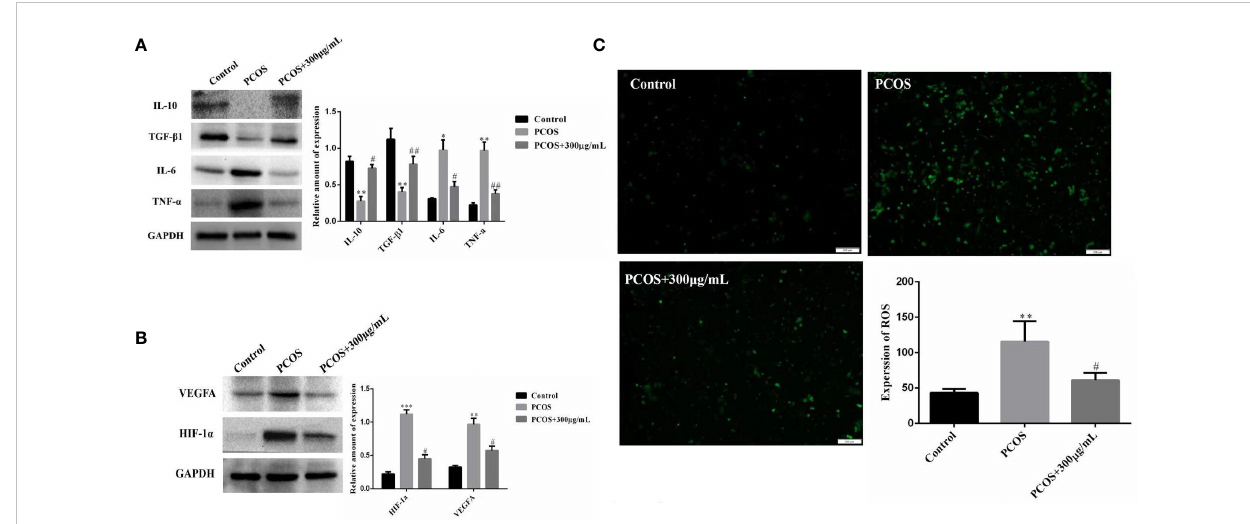
FIGURE 5 COS improves ovarian GCs in fl ammation and oxidative stress in PCOS patients. Effect of COS on the expression of in fl ammatory factors in ovarian GCs in patients with PCOS (A) . COS inhibits the expression of oxidative stress related factors in ovarian GCs of patients with PCOS (B) . COS decreases reactive oxygen species in GCs of patients with PCOS (C) . * P <0.05, ** P <0.01, *** P <0.001 vs Control group; # P <0.05, ## P <0.01 vs PCOS +300 m g/mL